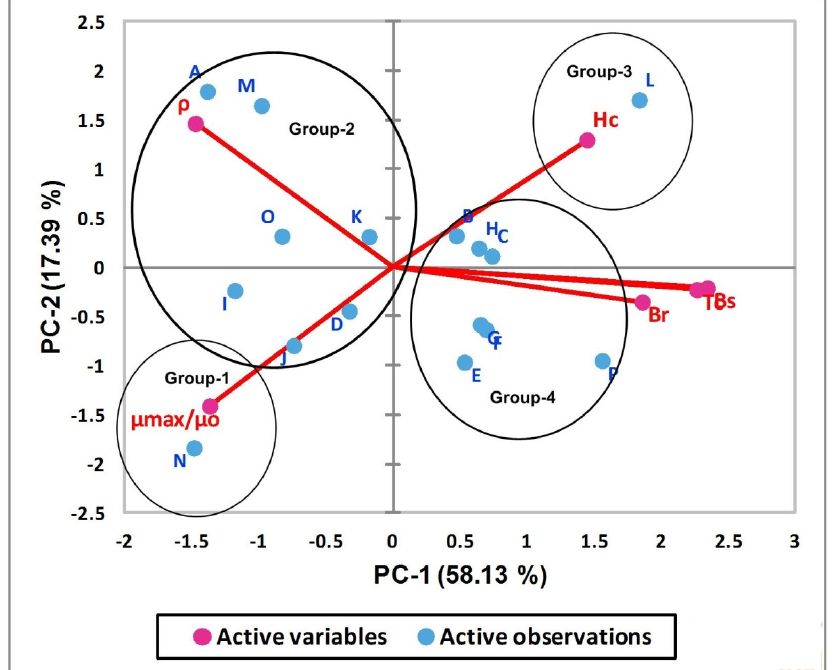
Figure 5. Bipolar PCA plot representing active variables and observations on the first two PCs space.